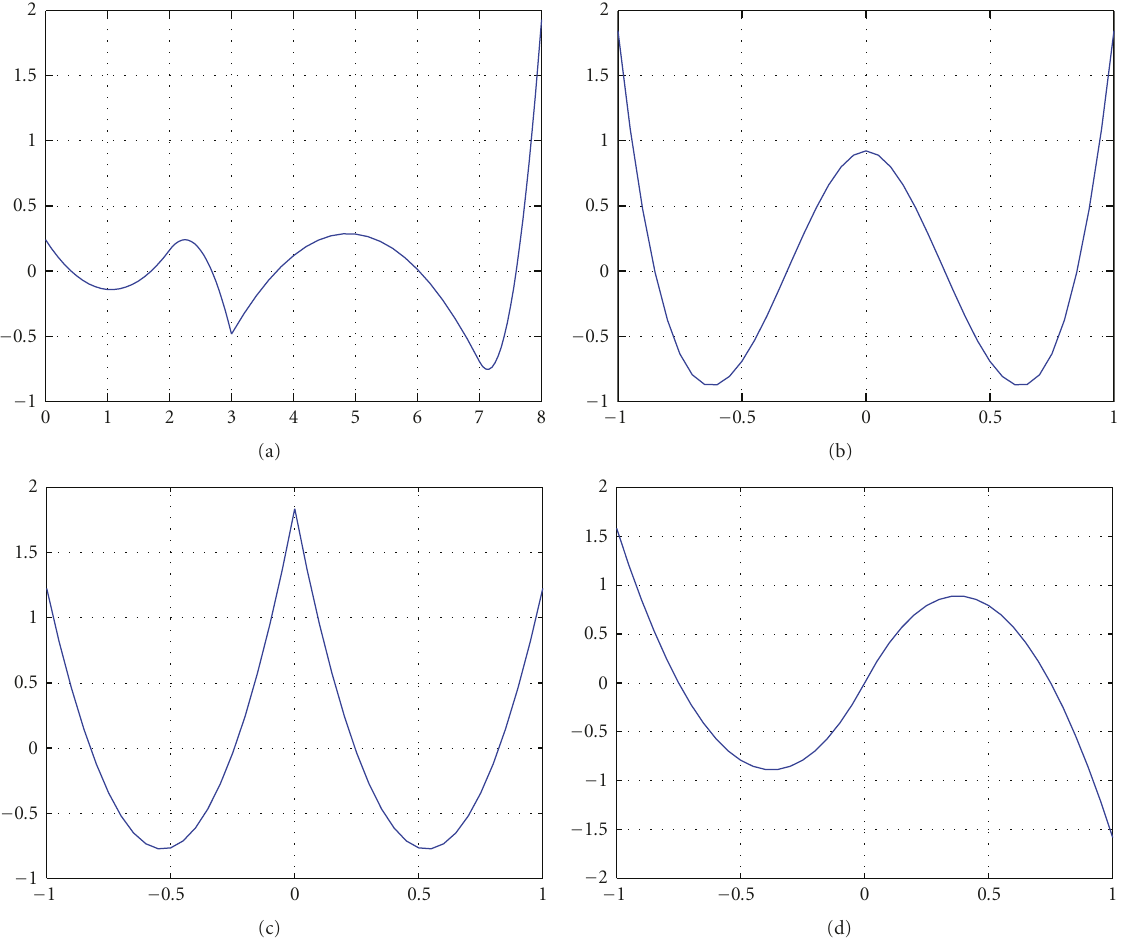
Figure 7: Normalized quadratic spline wavelet functions at resolution level j = 1 satisfying the following conditions: (i) regularity C 0 with six vanishing moments (a); (ii) regularity C 1 in the interval [ − 1,1] with four vanishing moments (b); (iii) regularity C 0 in the interval with four vanishing moments (c); (iv) regularity C 1 in the interval [ − 1,1] with three vanishing moments (d).